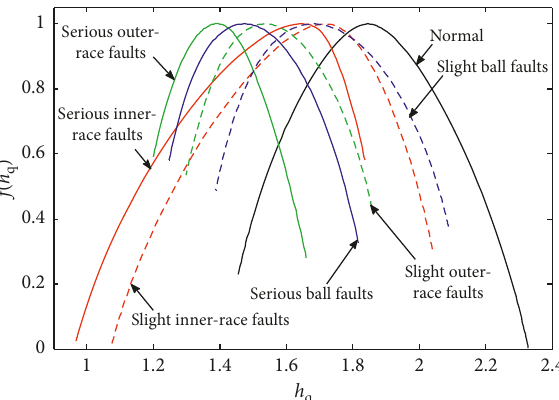
Figure 11: The multifractal spectrums of seven